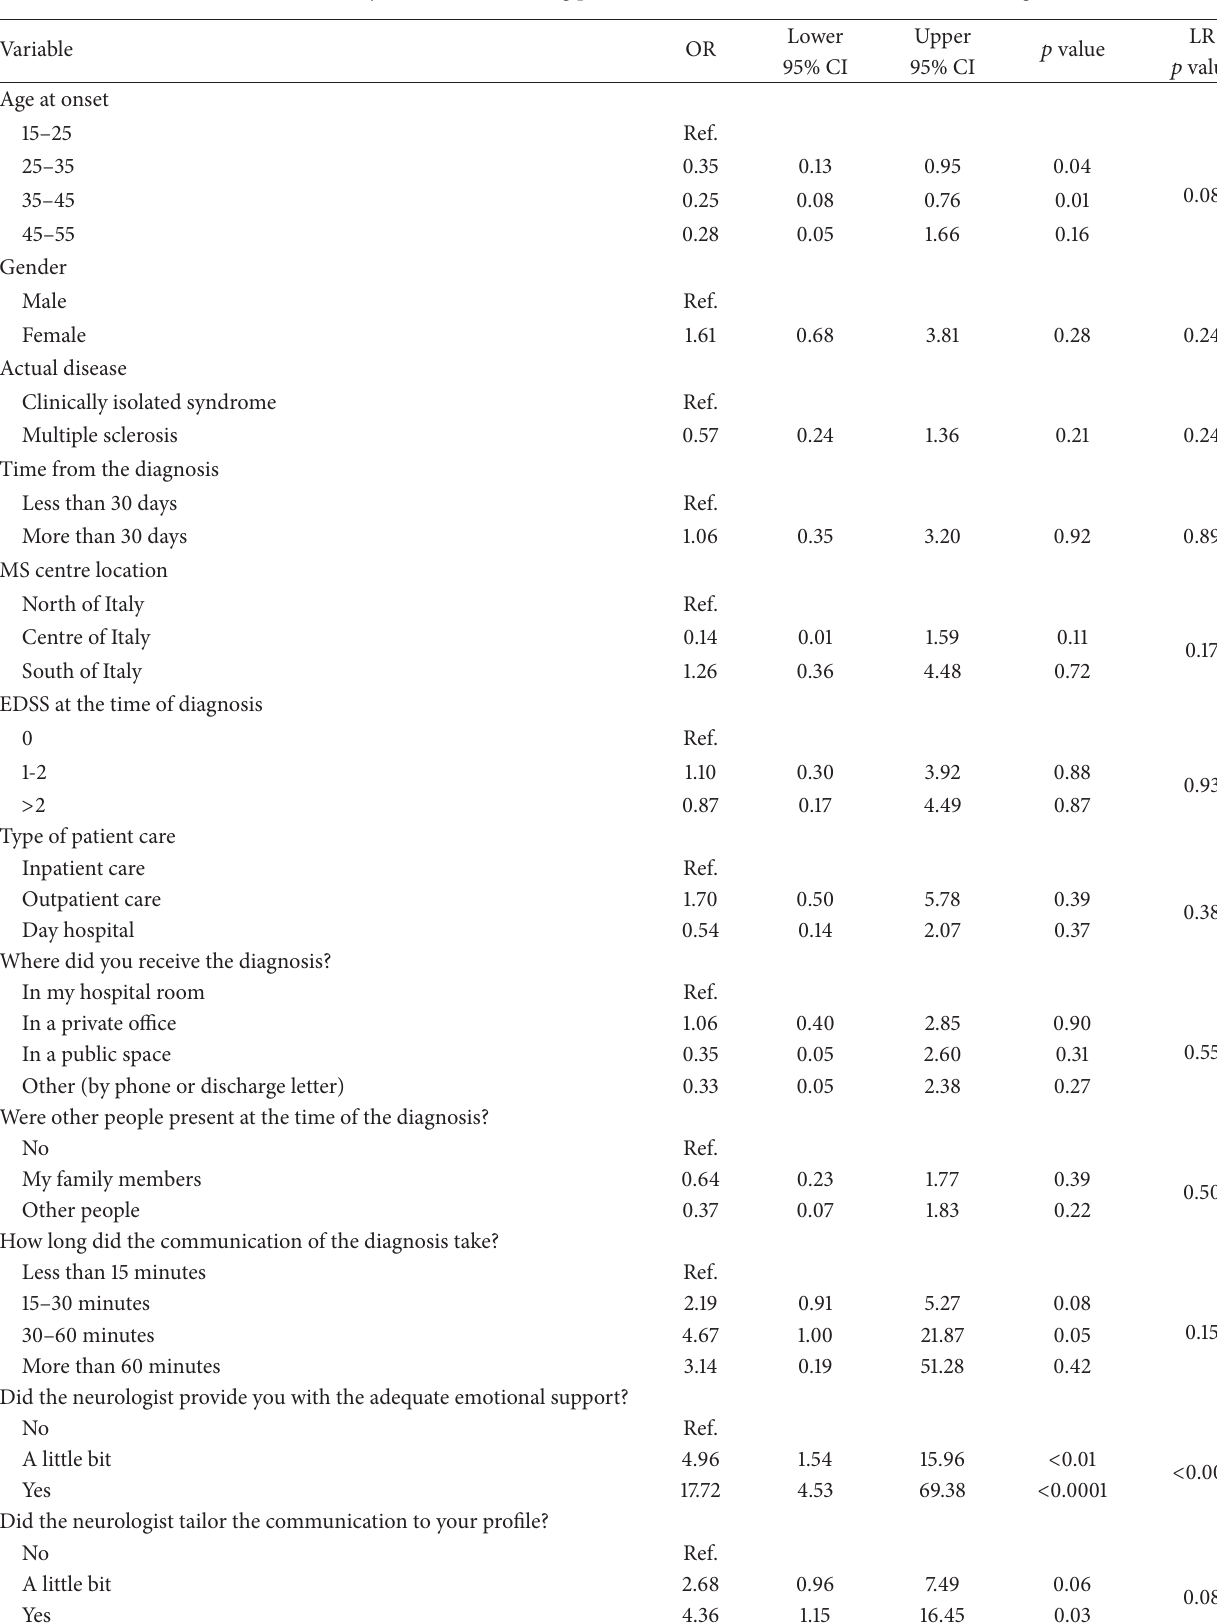
Table 3: Univariate analysis of factors affecting patients’ satisfaction with the disclosure of the